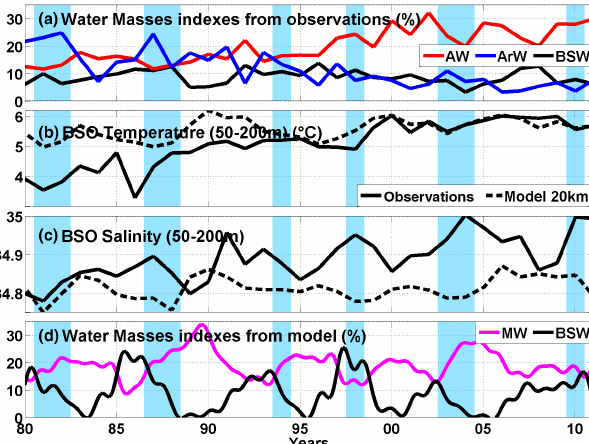
Figure 9. Interannual variations from 1980 to 2011 of (a) Atlantic Water in red (AW), Arctic Water in blue (ArW) and Barents Sea Wa- ter in black (BSW) index from in situ observations. (b) Temperature and (c) salinity (50–200m) at BSO section from observations (solid line), SINMOD model (dashed line). (d) Barents Sea Water (BSW) and meltwater (MW) from the SINMOD model (a low-passed filter (14 months) has been